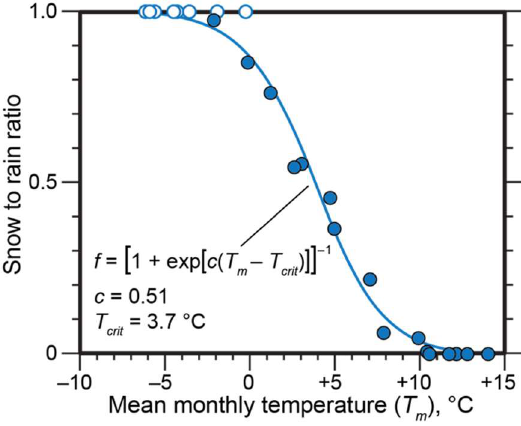
Figure 5. Snow to rain ratio (both in w.e.) recorded at two SNOTEL sites close to the study area and a best-fit function. Values represented by open symbols were truncated at 1.0 as snow precipitation exceeded total precipitation (i.e., ratios > 1.0) owing to excess accumulation due to wind drift.